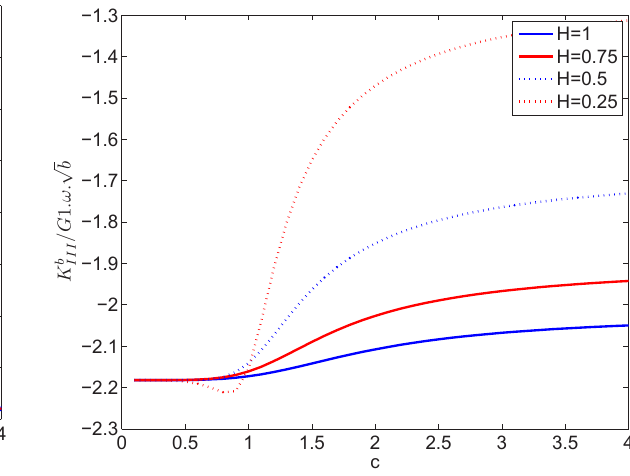
Figure 2: Variation of the normalized stress intensity factor at the edge of the crack with a/b.